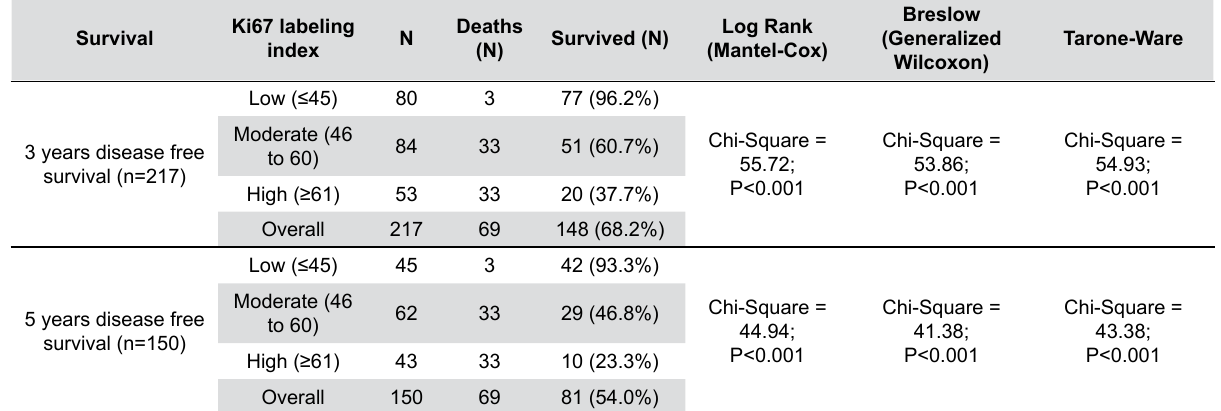
Table 3- Kaplan Meier Survival analysis: Ki67 labeling index and 3 years and 5 years survival analysis of oral squamous cell